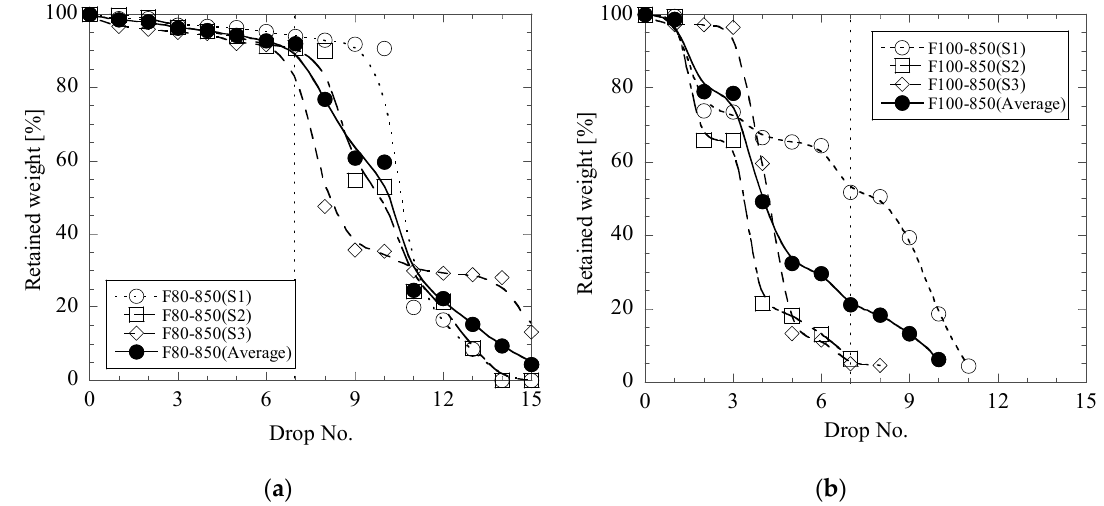
Figure 3. Relationships between retained weight of briquettes and drop number in drop test trials for briquettes of F80-850 ( a ) and F100-850 ( b ).